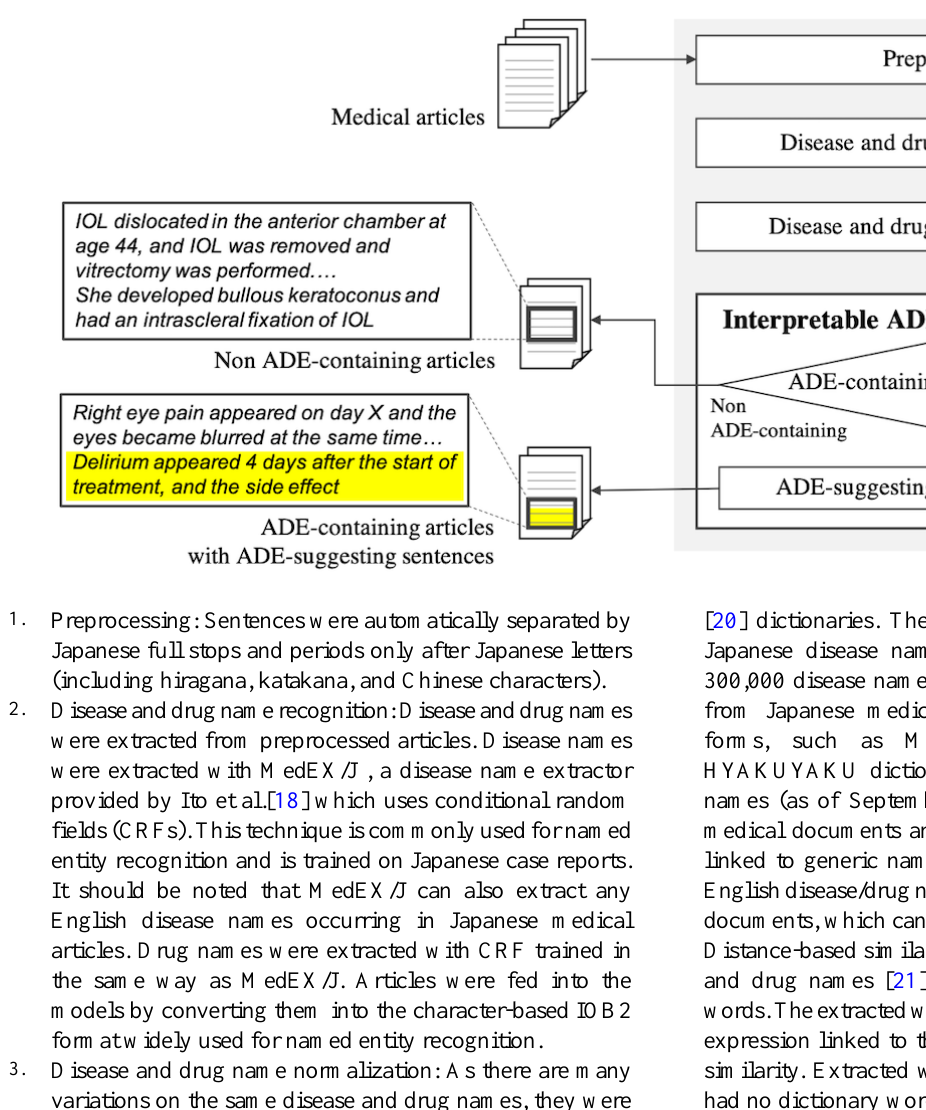
Figure 1. Architecture of the proposed system. ADE: adverse drug event; IOL: intraocular